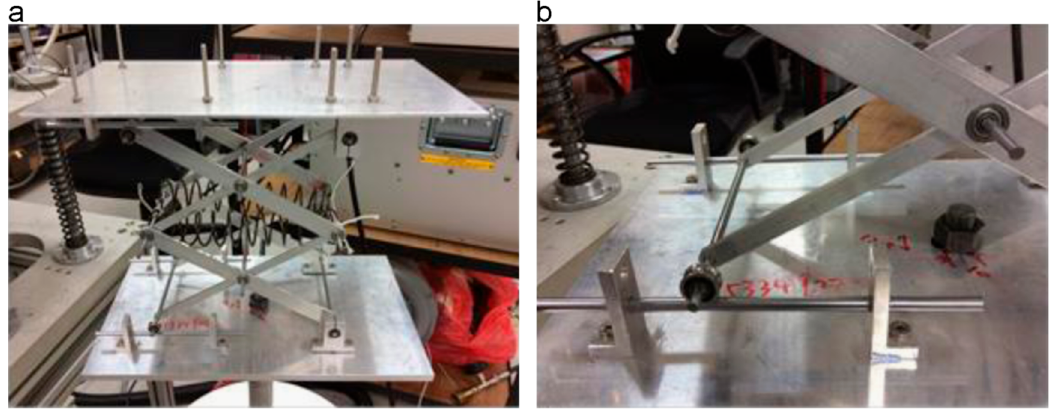
Figure 4. The prototype of the x-shaped vibration isolation system by Xiuting [53]; ( a ) prototype of the x-shaped; ( b ) Horizontal slide.